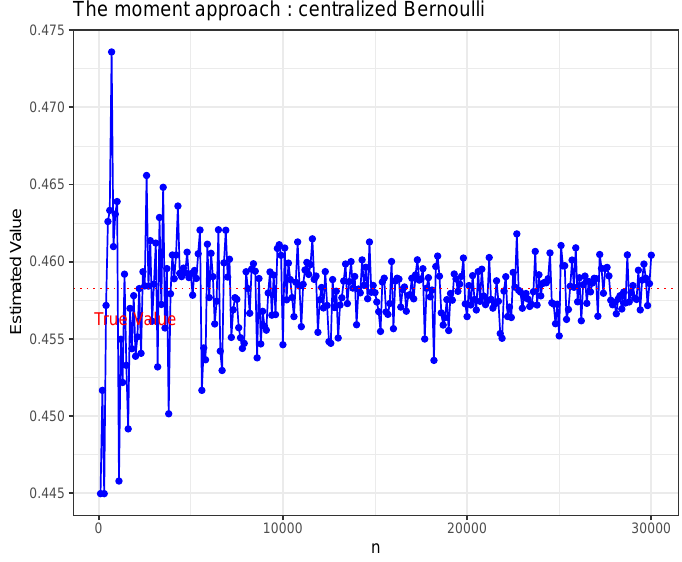
Figure 2. centralized